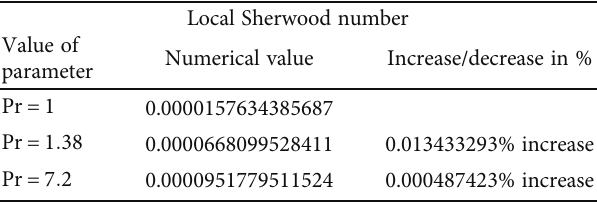
Table 8: Variability of the curve when Y = 0 : 5 in Figure 8(e).